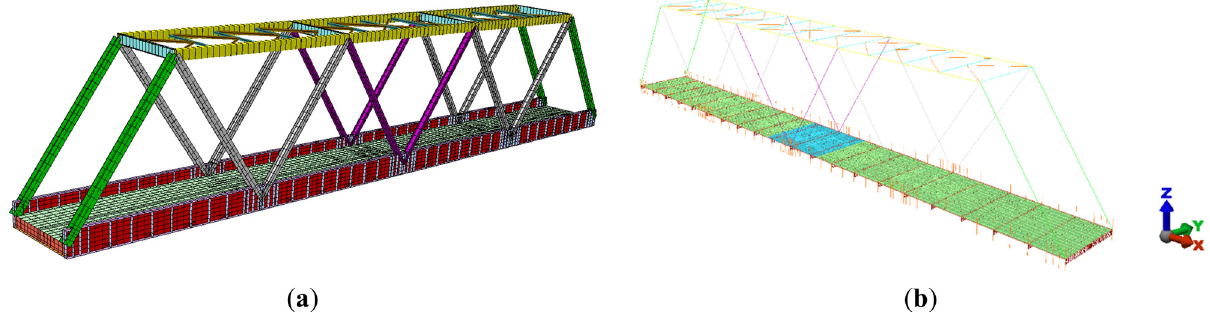
Figure 3: Numerical bridge models: ( a ) plate - frame model and ( b ) frame model. Source: The